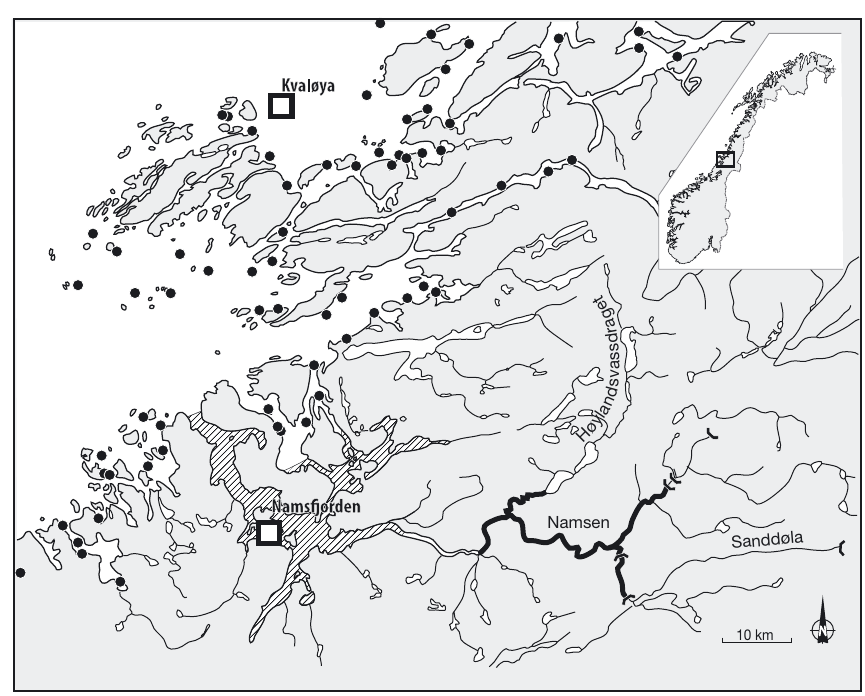
Fig. 1. Kvaløya Island, the Namsfjord and the River Namsen system, showing the areas (squares) where Atlantic salmon were captured with bag nets or bend nets on the coast and with bag nets in the fjord. The shaded area indicates the extent of the protected area of the national salmon fjord and black dots indicate Atlantic salmon farms. Data on farm locations and the pro- tection zone was found on the website of the Norwegian Directorate of Fisheries (https://www.fiskeridir.no). The inset shows the location of the study site in Norway. Graphics: Kari Sivertsen,